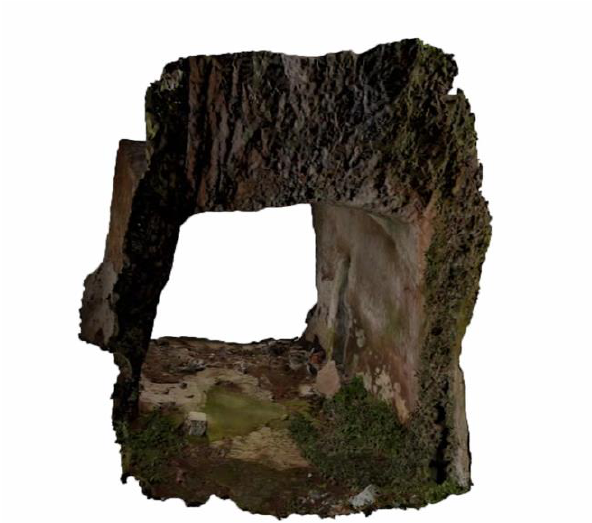
Figure 19. 3D model of the entrance area of a tuff quarry in Centocelle